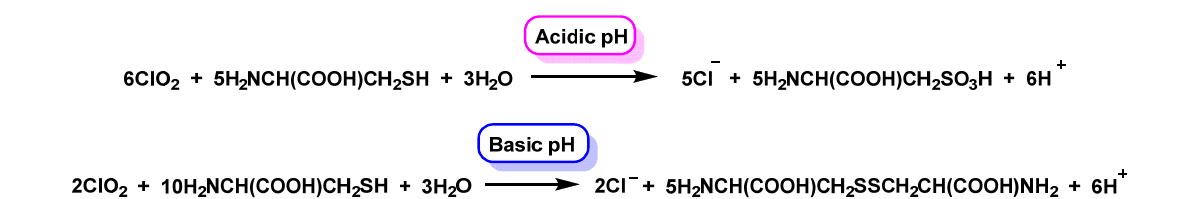
Figure 35. Reaction rate constants of ClO 2 with amino acids at 25 °C.